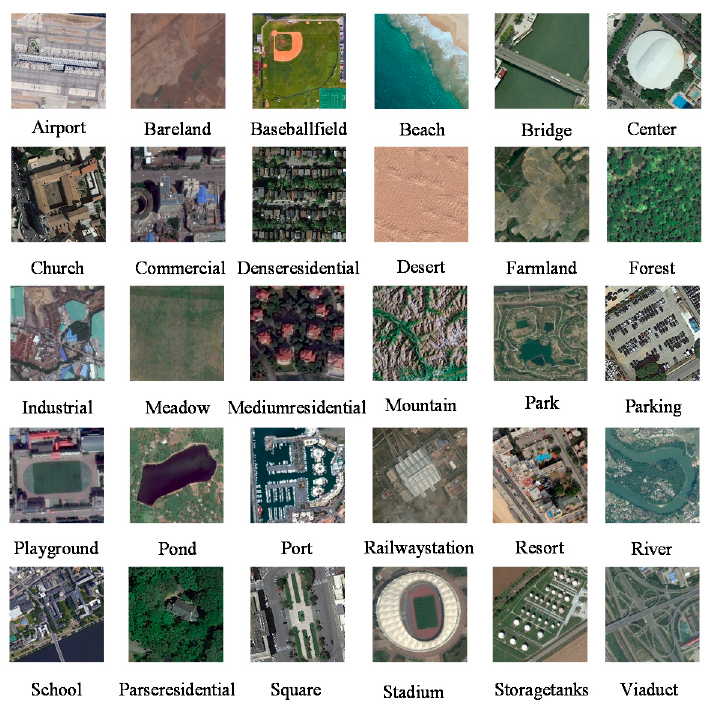
Figure 5. Aerial Image Dataset.